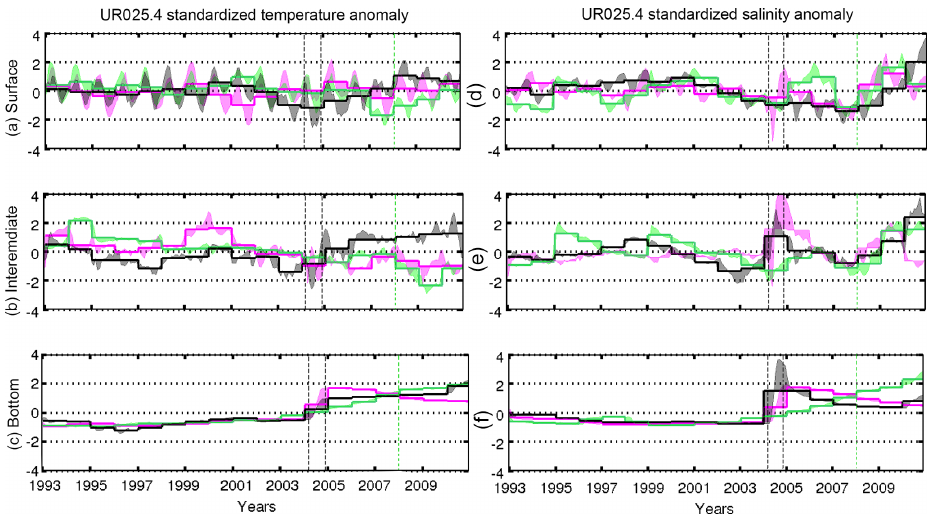
Figure 9. Same as Fig. 8 but for UR025.4; gray dashed lines show the periods of AABW formation in the Indian Ocean and Western Pacific sectors, while green dashed lines show the beginning of AABW formation in the Weddell